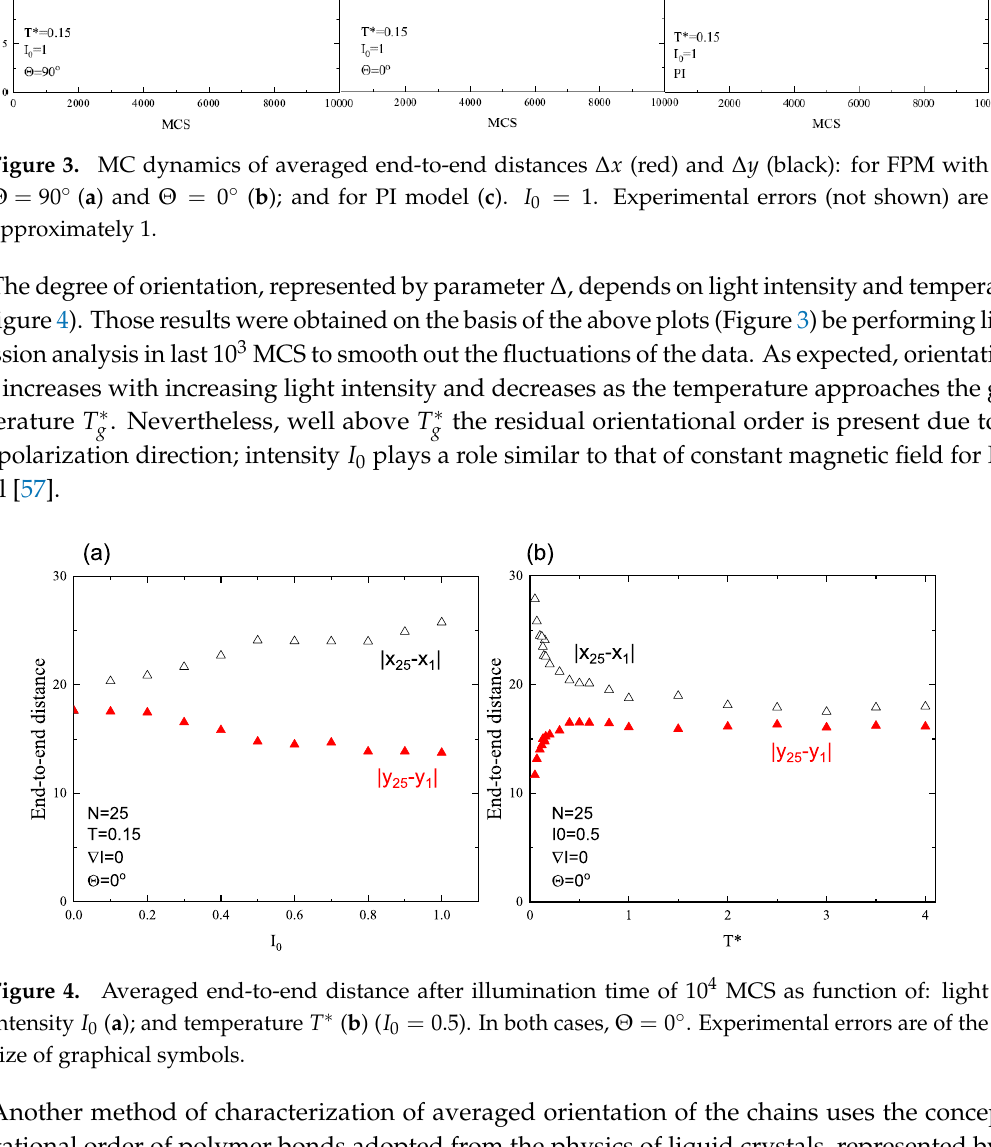
= 1. Experimental errors (not shown) are 0